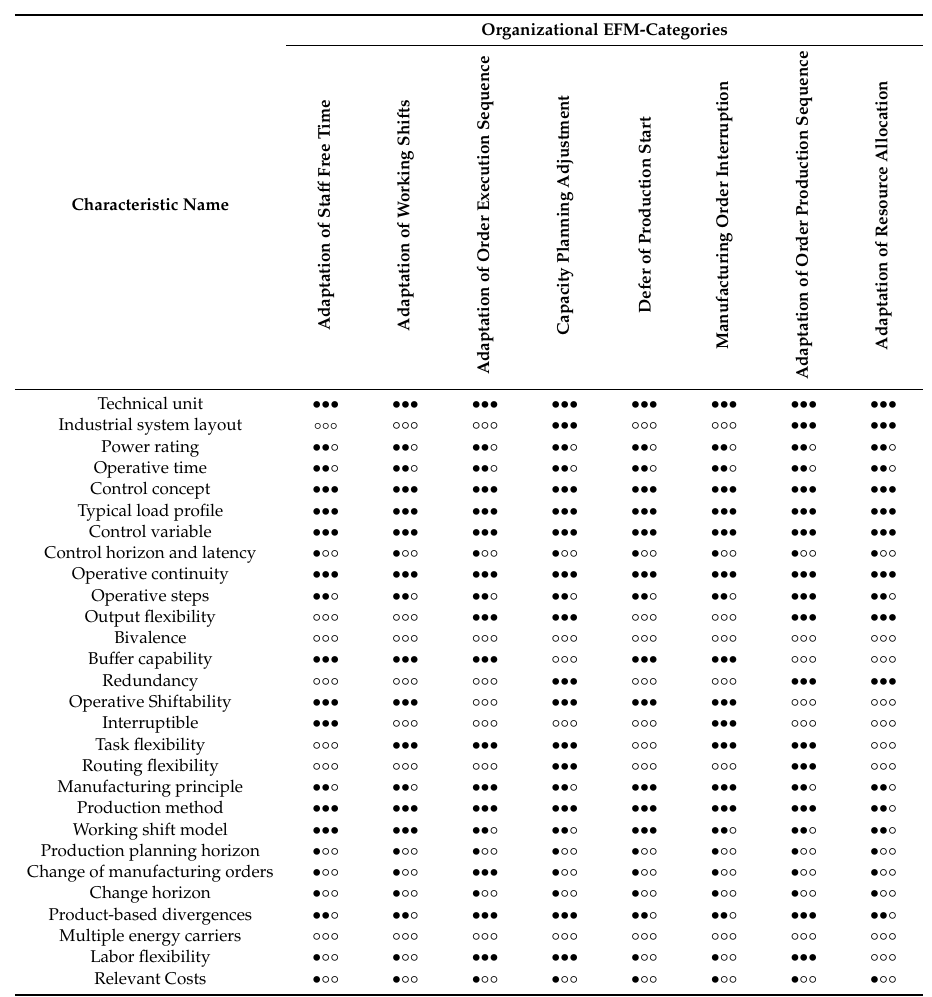
Table 2. Level of influence of the physical, operative and production characteristics in the existence of organizational EFMs 1